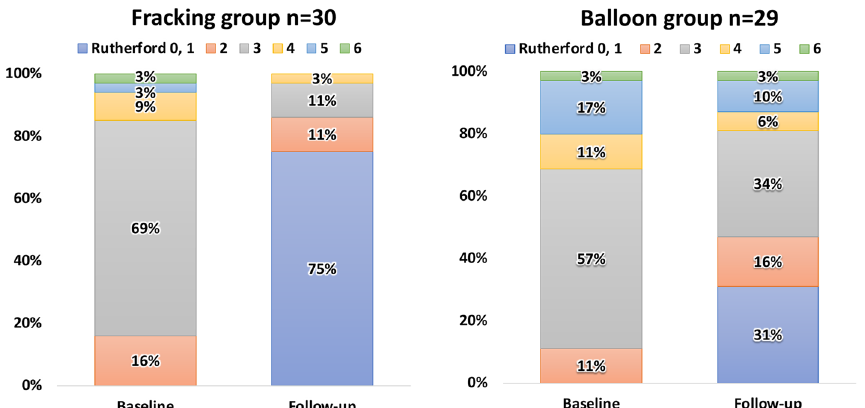
Fig. 3 Change in Rutherford classification for the fracking and the balloon groups at baseline and follow-up. The Rutherford classification improved similarly in both groups